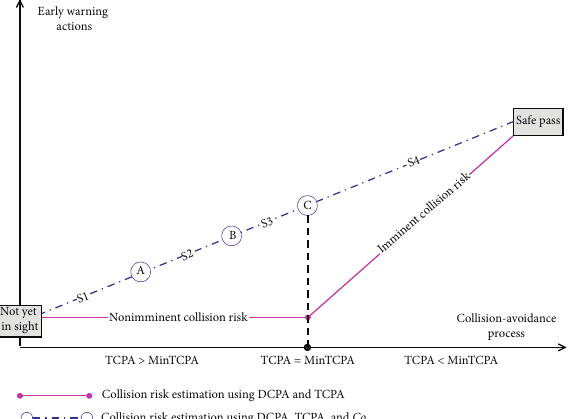
Figure 8: Comparison of the early warning process for two ships in an inland waterway proposed in this study. A: understanding each other’s movements. B: unifying collision-avoidance strategies. C: taking coordinated maneuvering actions. S1: not yet understanding each other’s movements. S2: not yet unifying collision-avoidance strategies. S3: not yet taking coordinated maneuvering actions. S4: verifying collision-avoidance effectiveness. C o : degree of coordinated collision-avoidance of two ships. DCPA: distance to the closest point of approach; TCPA: time to the closest point of